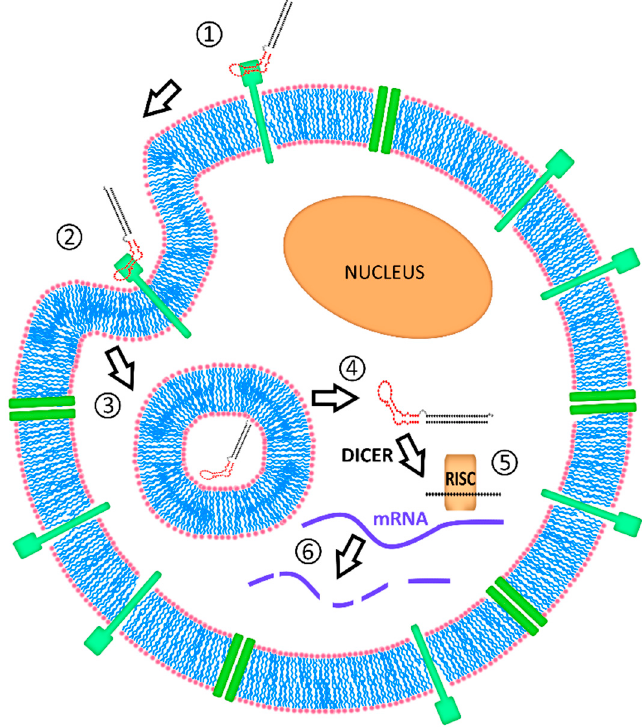
Figure 1. Concept of aptamer siRNA chimera (AsiC) delivery into a target cell. The AsiC molecule binds through the aptamer part (red) to the target molecule (in green, e.g., a cell-specific receptor) on the cell-surface (1); Upon endocytosis, AsiC molecules are internalized into the cell (2); where they, at least temporarily, end up in vesicles of the endosome or lysosome (3); Molecules escaping the endosomal compartment (4) will be recognized by RNA interference (RNAi) machinery. The ribonuclease Dicer will bind to the siRNA part of the AsiC (black double strand), cut it off the aptamer and load it into the RNA-induced silencing complex (RISC), an assembly of proteins further mediating the specific degradation of messenger RNAs (mRNAs) (5); The Argonaute protein AGO2, one major component of the RISC, unwinds the siRNA double strand and retains only one of the two strands, the guide strand. As a result, mRNAs matching this RISC-loaded guide strand can be cleaved, and the expression of the gene corresponding to this mRNA will be decreased (6).